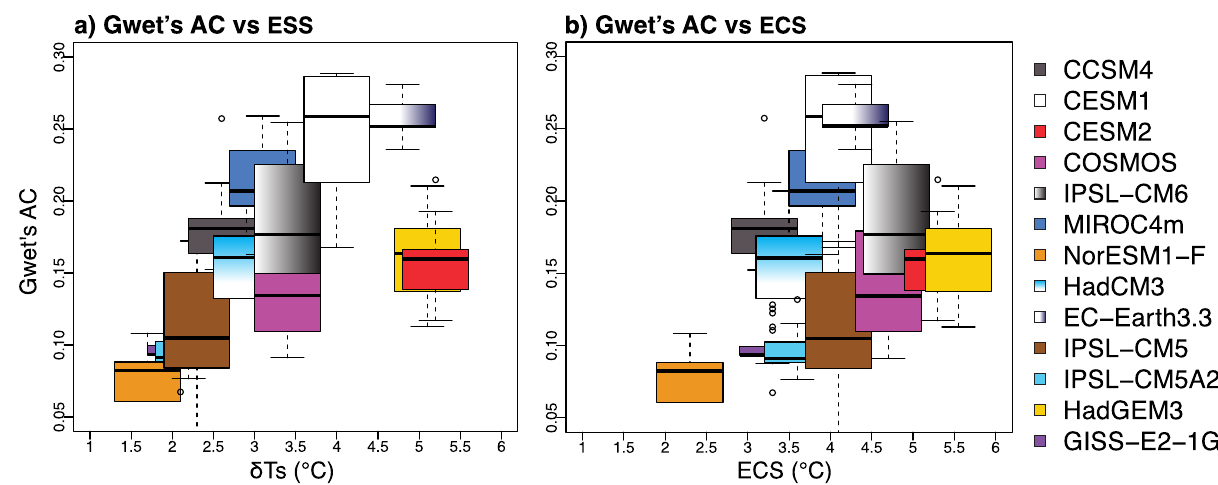
Fig. 5 Relationship between earth system sensitivity (ESS, °C), equilibrium climate sensitivity (ECS, °C), and ability to reproduce mid-Pliocene proxy hydroclimate state by different models. Proxy data-model agreement measured by Gwet ’ s ACs as a function of a global mean surface warming ( δ T s, which quanti fi es ESSs), and b ECSs of these models. δ T s and ECSs are from ref. 33 . Boxplots show the spread of Gwet ’ s AC (1st, 2nd, and 3rd quantiles, upper and lower fences, and outliers if any) from using 20 – 60% of δ ( P – E ) as thresholds